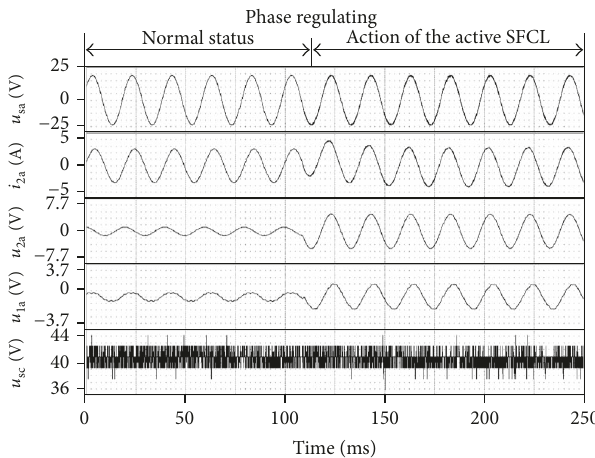
Figure 8: Phase-regulating characteristic of the active SFCL proto- type under the commissioning